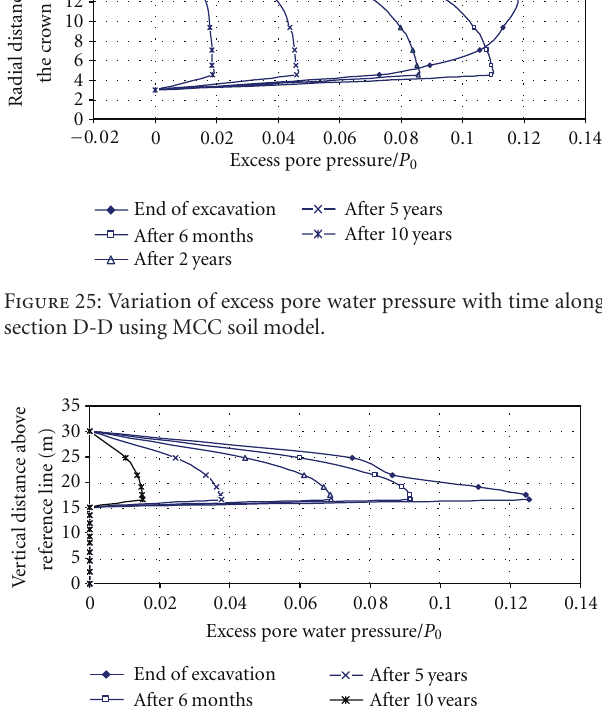
Figure 28: Variation of excess pore water pressure with time along section A-A using reduced k 0